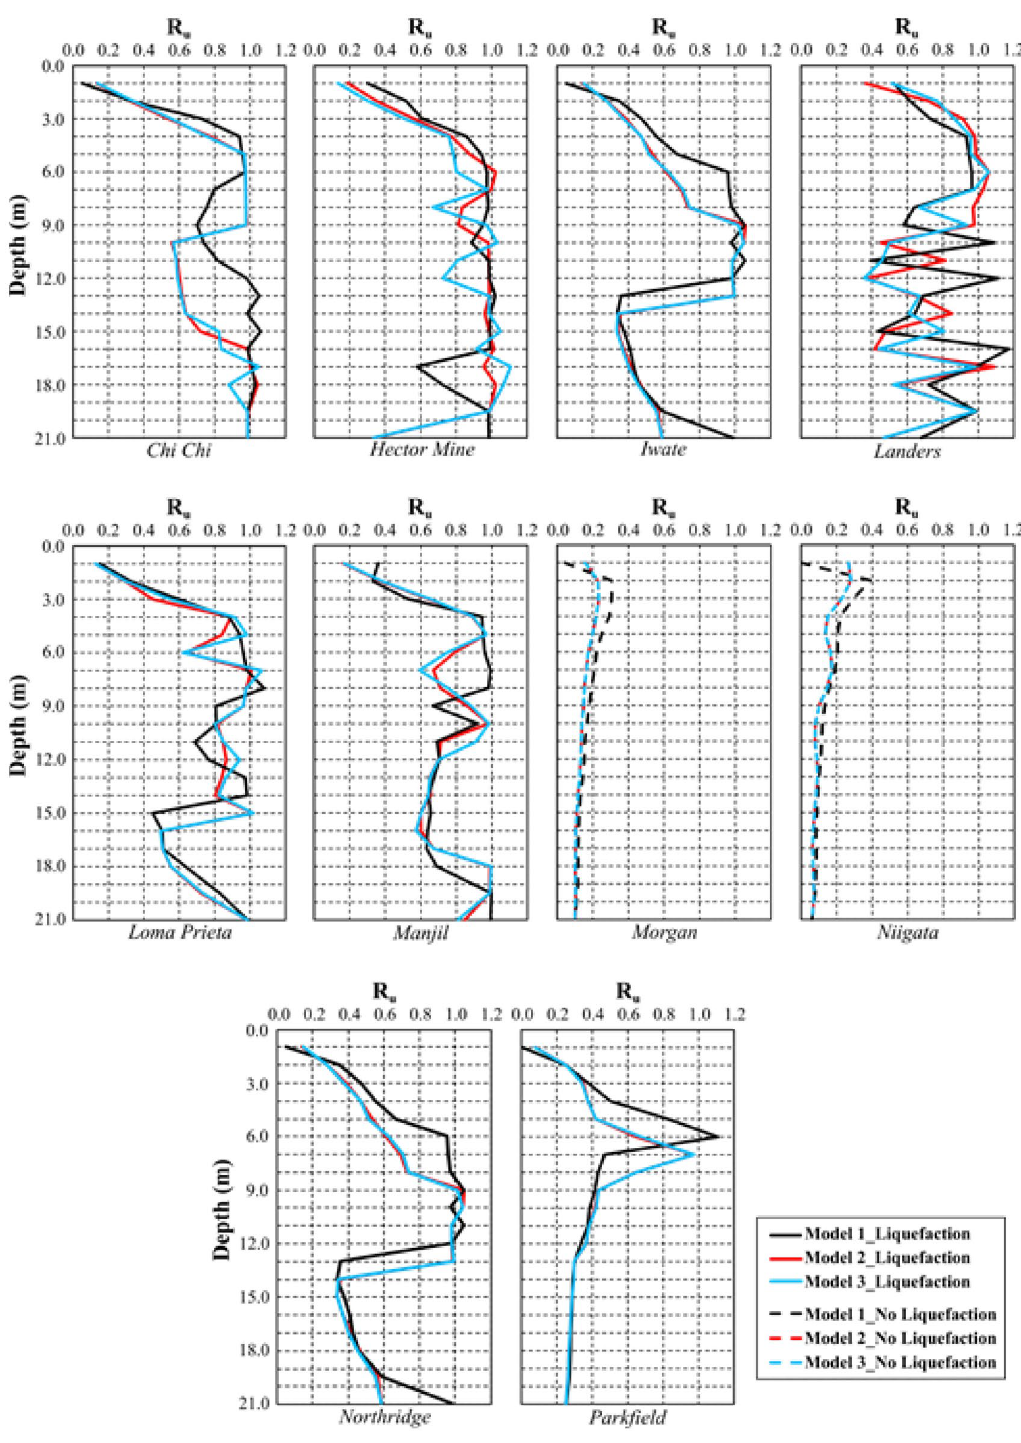
Figure 20. The variations in the R u parameter with depth for Model 1, 2 and